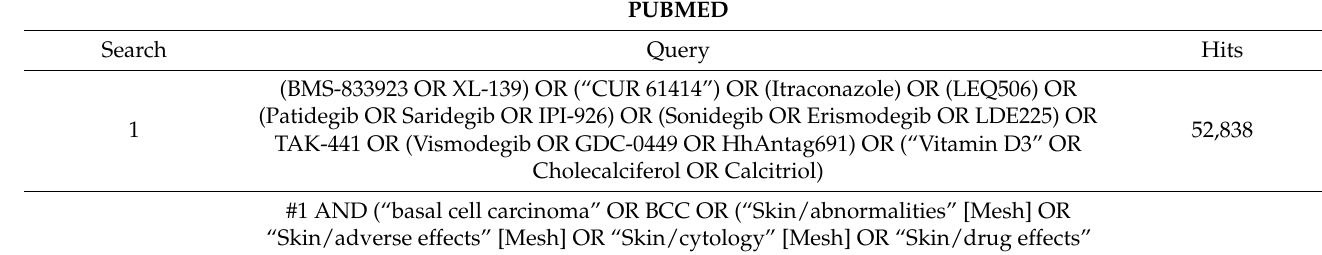
Table 5. Search strategy. All search queries used for our searches. Cutane* covers all words that start with “cutane” e.g., cutaneous, and cutaneously. The latest search was performed 10 June 2022.